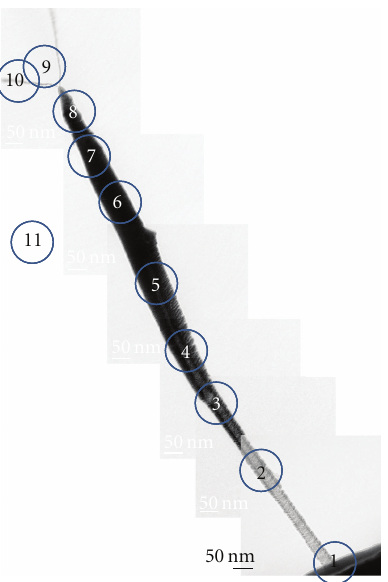
Figure 6: Multipoint EDS measurement of the hybrid nanowire using TEM (numbers 1–11 represent measurement points).